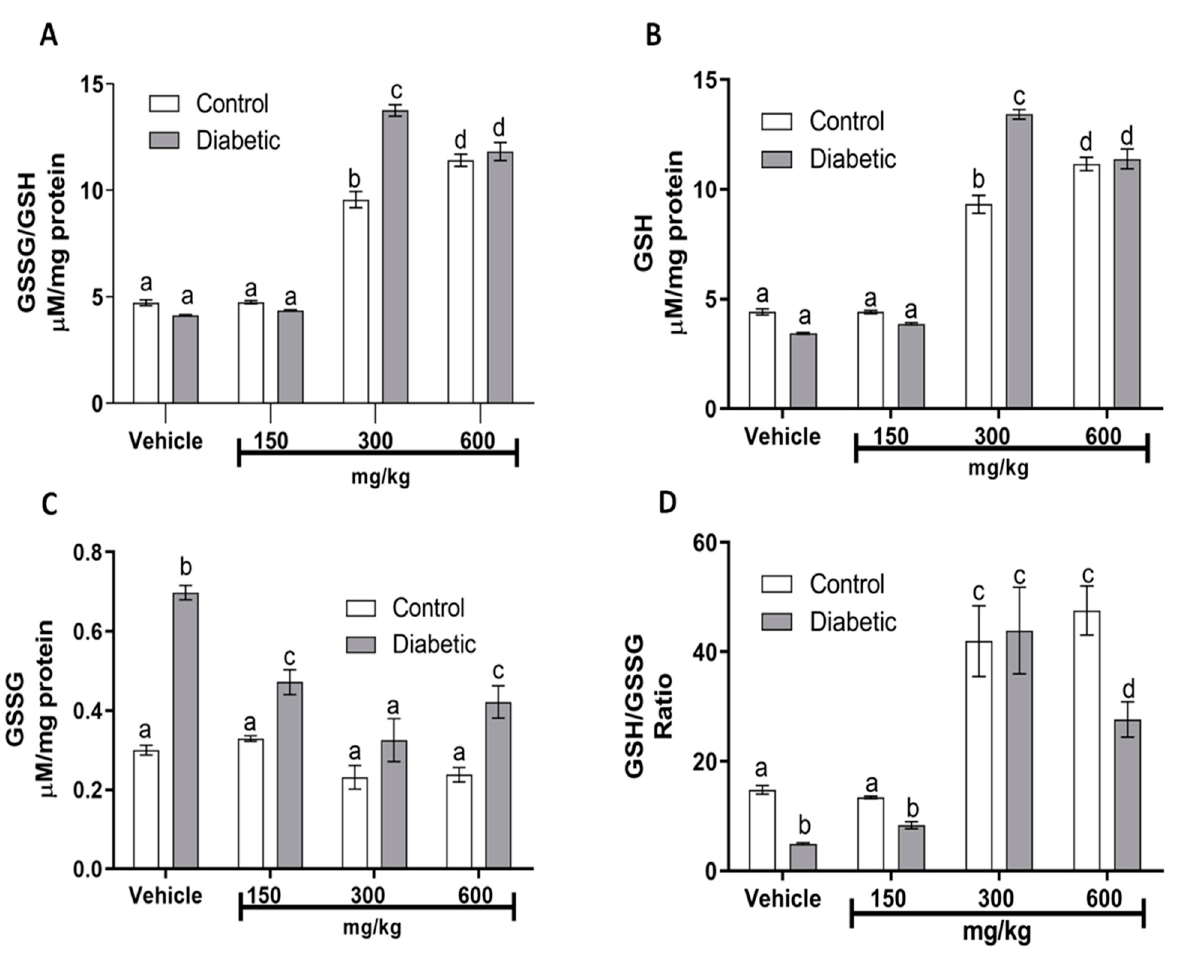
Figure 1. Effects of guishe on redox biomarkers (glutathione) in kidney mitochondria. ( A ) Total glutathione (GSSG/GSH); ( B ) reduced glutathione (GSH); ( C ) oxidized glutathione (GSSG); ( D ) glutathione ratio (GSH/GSSG ratio). GSSG/GSH and GSSG were determined in pools from isolated kidney mitochondria from each group—in all cases, at the end of the 5 weeks of treatments. Values express the mean ± SEM of at least n = 3 rats. ANOVA with post hoc Tukey HSD test for unbalanced data was performed. Means not sharing the same superscript are significantly different ( p ≤ 0.05). Source: authors’ own elaboration. Table 2. Enzymatic determination for superoxide dismutase, catalase, and glutathione peroxidase. Enzyme Units